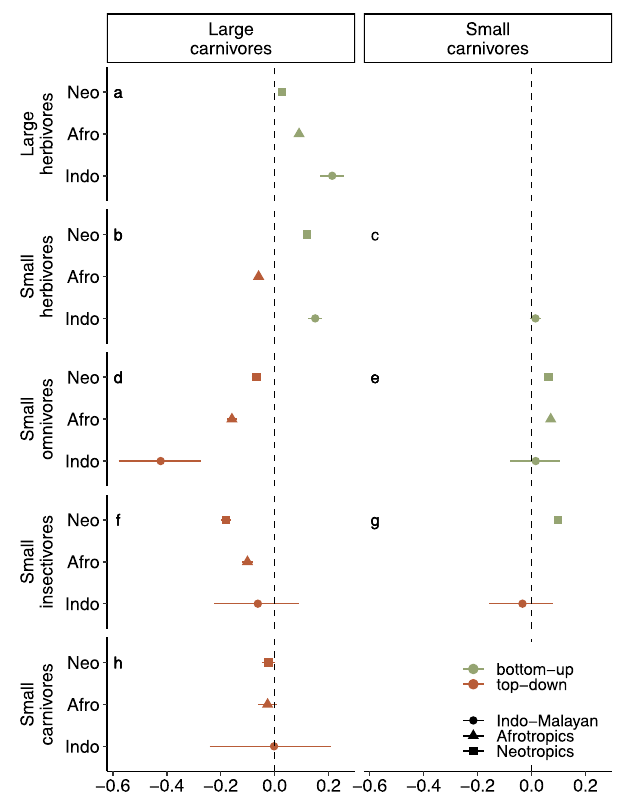
Fig. 4 |Bottom-up andtop-down processesasdeterminantsofthedielactivity oftropicalmammals. Centre of bars represent the mean coef fi cient estimates and bars show the 95% con fi dence intervals of the (GLMM) fi tted to assess the rela- tionship between the activity of species groups. The fi rst column includes the relationship between the activity of large carnivores ( n =747) and prey ( a large herbivores n =191,294, b small herbivores n =58392, d small omnivores n =8098, and f smallinsectivores n =7120)and h therelationshipbetweentheactivityoflarge carnivores and small carnivores ( n =2280). The second column includes the rela- tionship between small carnivores and potential prey ( c small herbivores, e small omnivores, and g small insectivores). Note that n represents the total number of independent events for each species group and size. Green symbols illustrate a positive effect (bottom-up) and brown symbols illustrate a negative (top-down) relationship. Effects were considered signi fi cant when the 95% CI did not overlap zero (dashed horizontal lines). Neotropical sites “ Neo ” are denoted with squares, Afrotropical sites “ Afro ” with triangles, and Indo Malayan “ Indo ” with